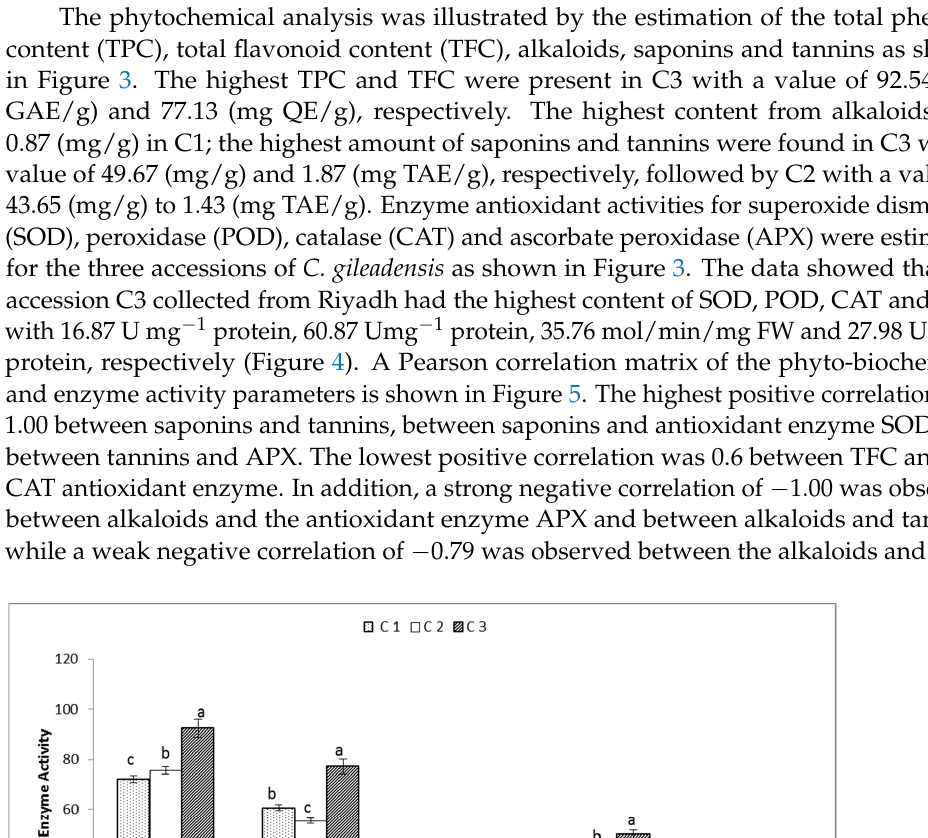
Figure 2. Phylogeny tree for C. gileadensis accessions in KSA from 18 S rRNA sequences (highlighted in red) compared with other relatives of the closest species obtained from GenBank from different localities. Bootstrap tests were performed with 2000 replications.